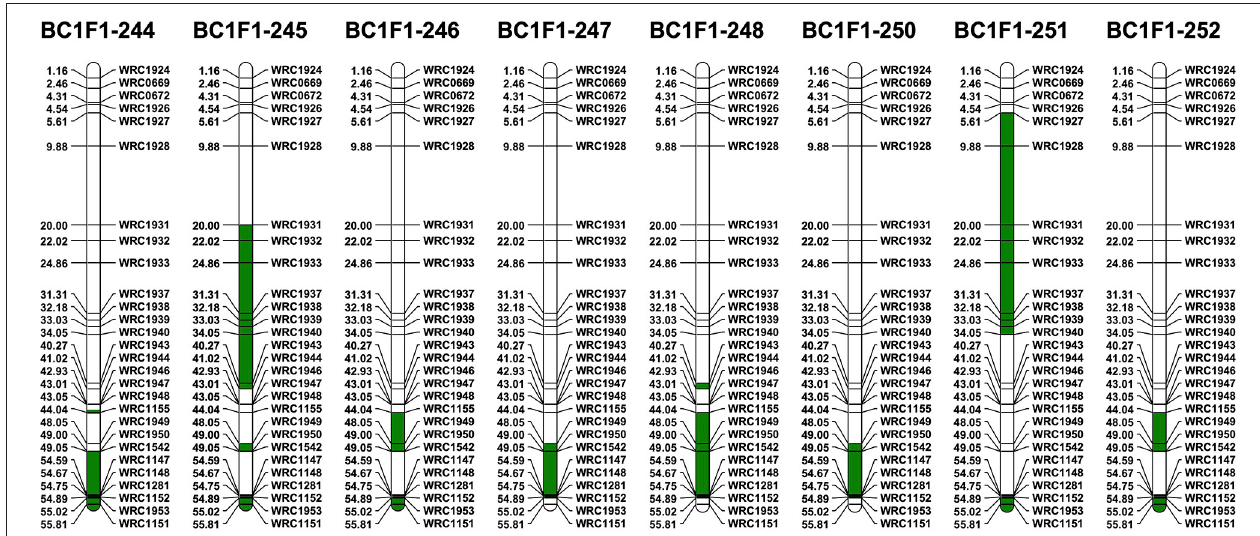
FIGURE 6 | Physical position of Ae. tauschii segment (green) within the retained 5D chromosome in the BC 1 F 1 lines using the 5D-chromosome-specific polymorphic KASP markers between CS and Ae. tauschii . Marker positions are displayed as 1 × 10 − 7